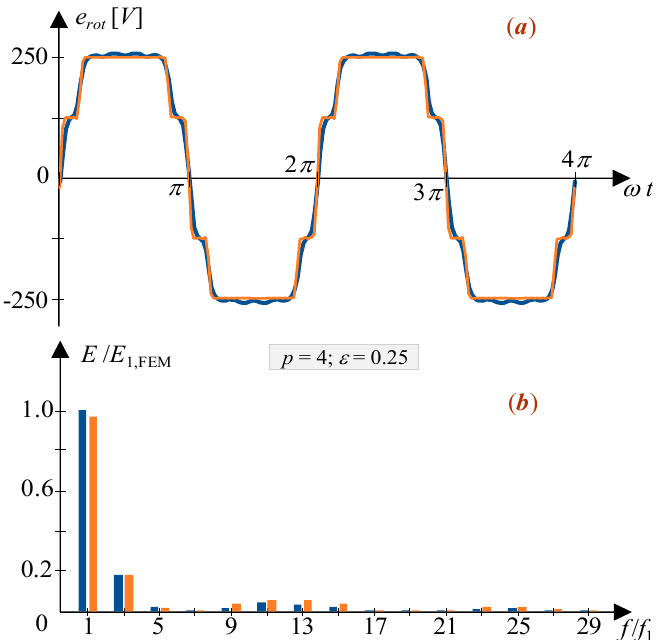
Figure 9. No-load voltage induced in a stator phase at 1500 rpm. ( a ) Time behavior; ( b ) amplitude frequency spectrum in p.u. Theoretical (brown line) and FEM values (blue line).